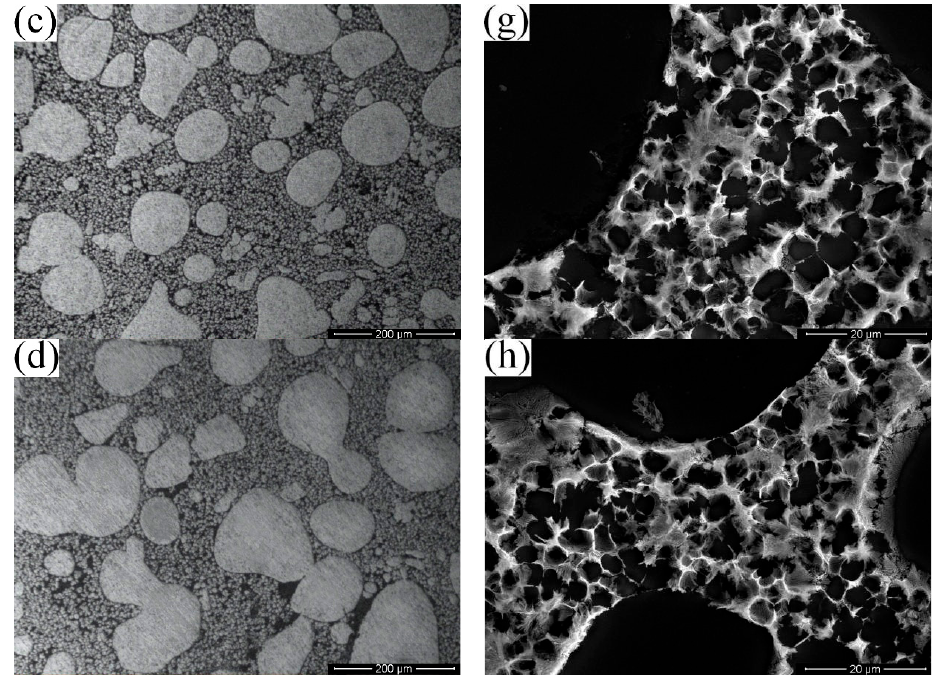
Figure 4. Microstructure of rheo-diecasting by SIM at different holding times ( a , e ) 0 min; ( b , f ) 3 min; ( c , g ) 5 min and ( d , h ) 10 min.